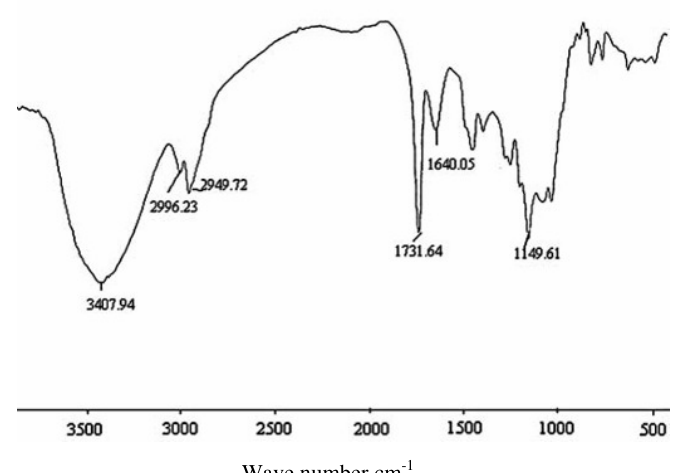
Figure 7. IR spectra of microwave synthesized grafted polyacrylamide-cross-linked chitosan